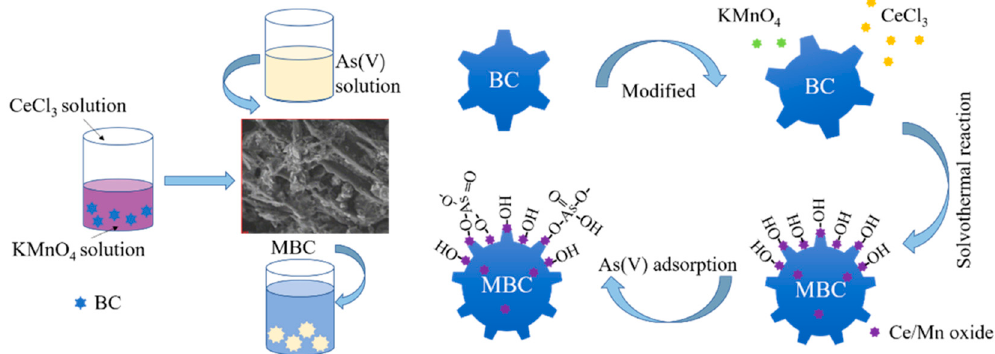
Figure 6. Schematic diagram of possible mainly mechanism for the As(V) adsorption.